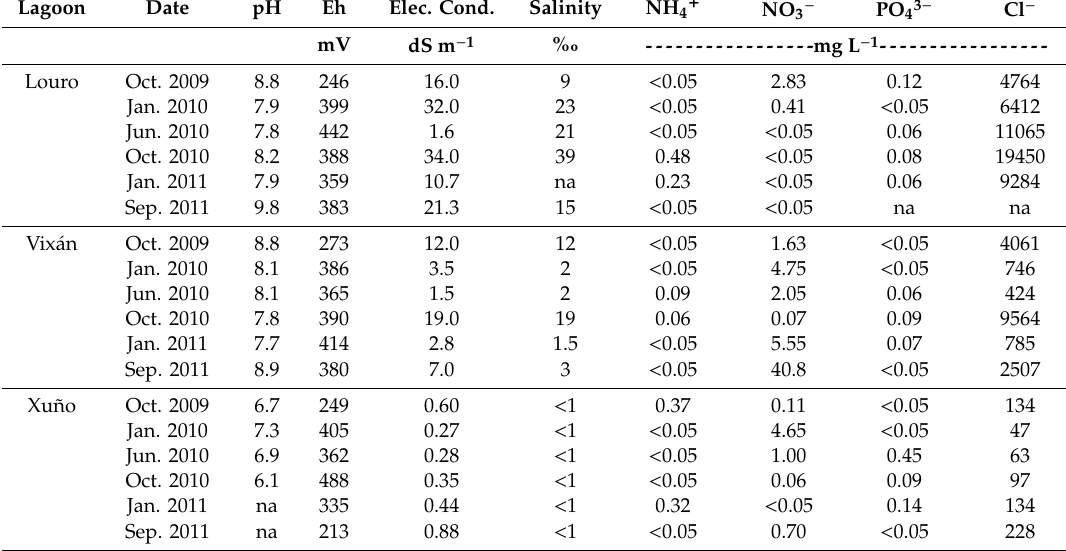
Table 1. Physicochemical characteristics and composition of water in the lagoons (na: not analyzed). Lagoon Date pH Eh Elec. Cond.